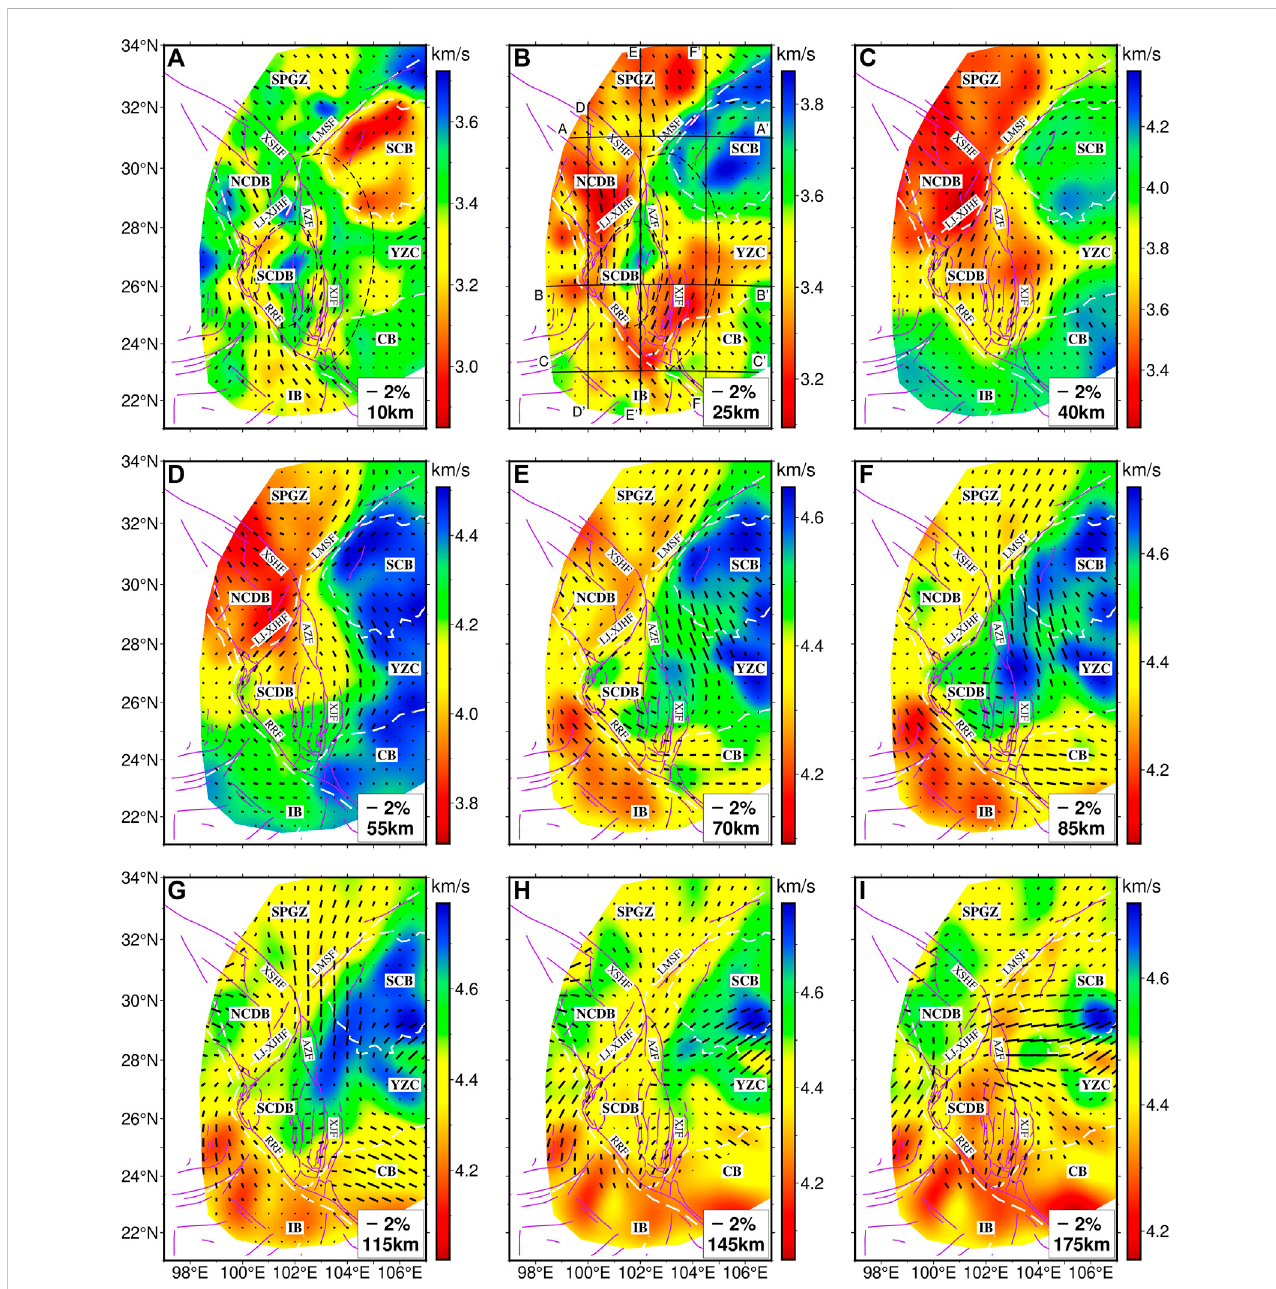
FIGURE 5 Map views of the 3-D shear wave velocity and azimuthal anisotropy structure at different depths. (A – I) Purple lines and white dashed lines are the faults andblockboundaries,respectively(theabbreviationsoffaultsandblocksarethesameasFigure1).Short blacklinesrepresenttheazimuthalanisotropy.Black dashed lines mark the inner and intermediate zones of the Emeishan large igneous